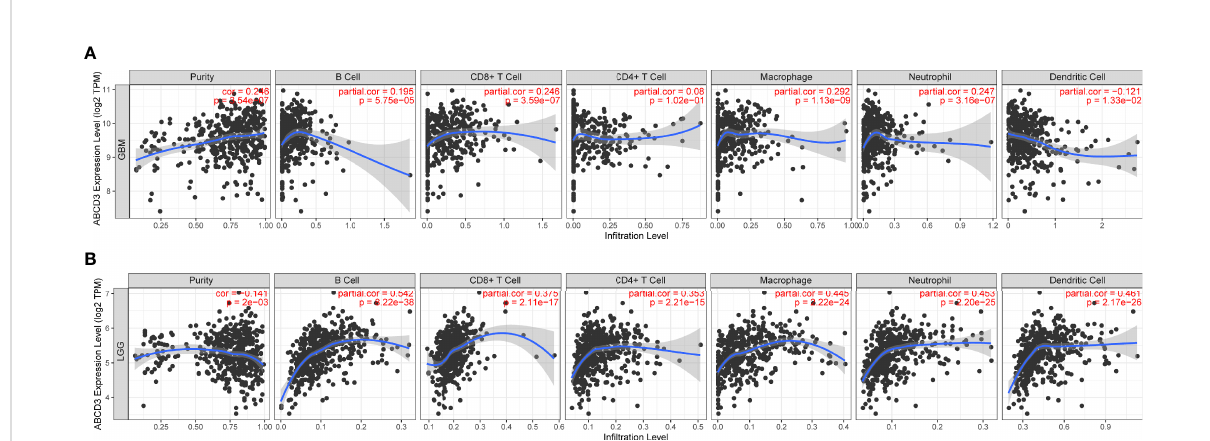
FIGURE 5 The ABCD3 expression level has a correlation with the tumor-in fi ltrating levels from TIMER. (A) ABCD3 expression has positive correlations with in fi ltrating levels of B cell, CD8 + T cell, macrophage, and neutrophil, while it has a negative correlation with dendritic cells in GBM. (B) ABCD3 expression has a signi fi cant positive correlation with all immune in fi ltration cells in LGG.